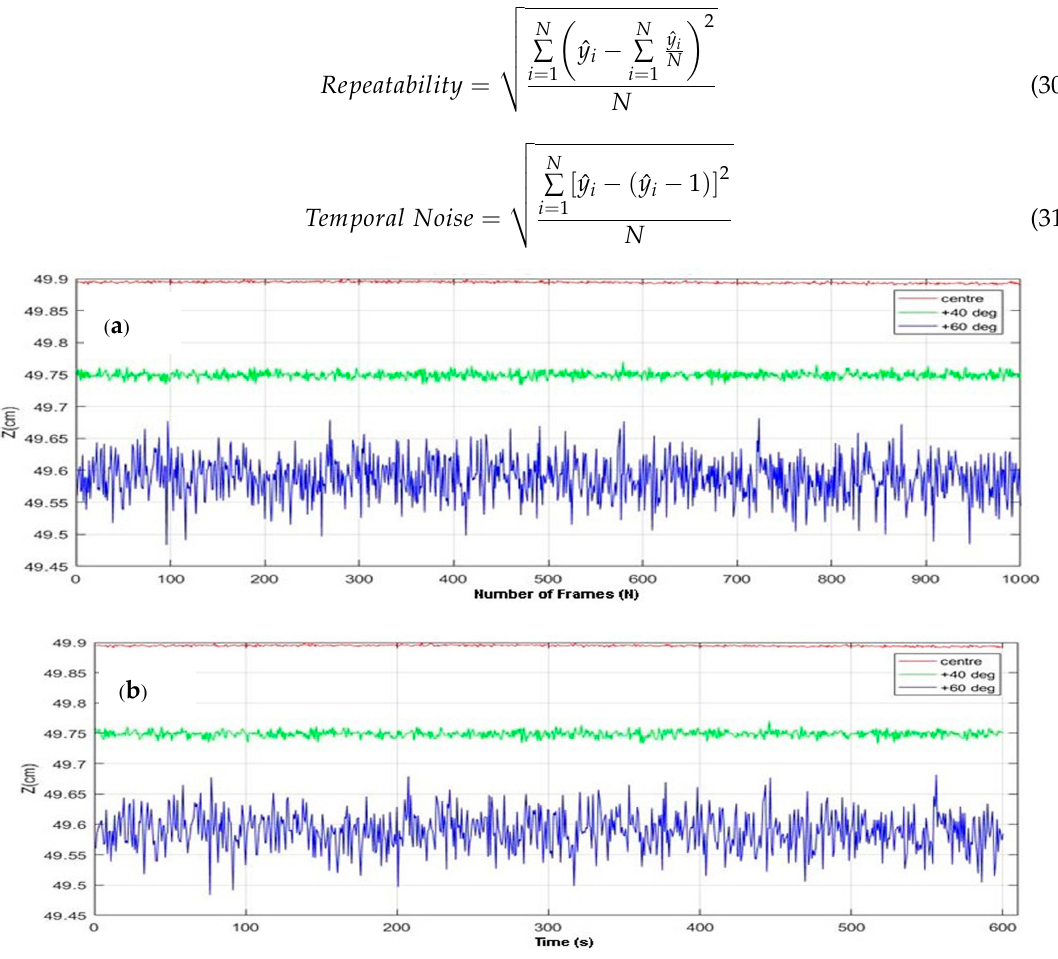
Figure 9. Measured Z at different fields of vision (FoVs) ( a ) for 1000 frames ( b ) for 10 min.